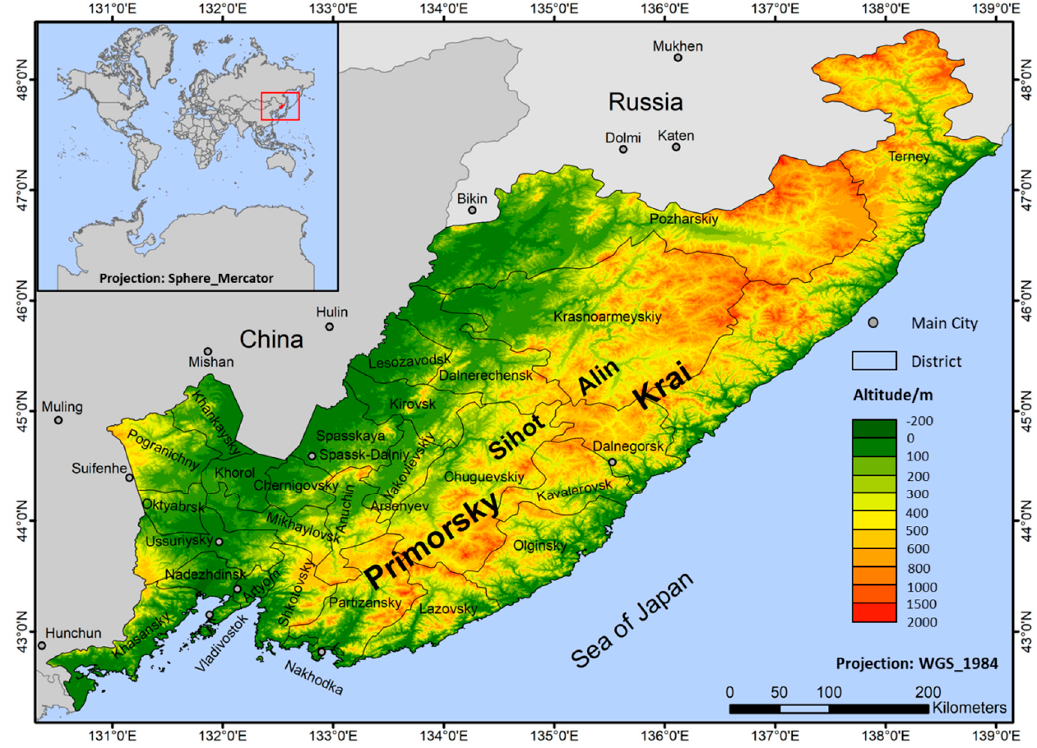
Figure 1. Topographic map of Primorsky Krai. Primorsky Krai covers an area of 15.87 million hectares, and the forest area is approximately 12.3 million hectares, accounting for 77.5% of the total area. The shapefiles data used in the basemap is from the Resource and Environmental Science Data Center of the Chinese Academy of Sciences (http://www.resdc.cn). The digital elevation model data used in the topographic map comes from http://www2.jpl.nasa.gov/srtm. Sihot Alin from the northeast to the southwest through the eastern and central parts of the